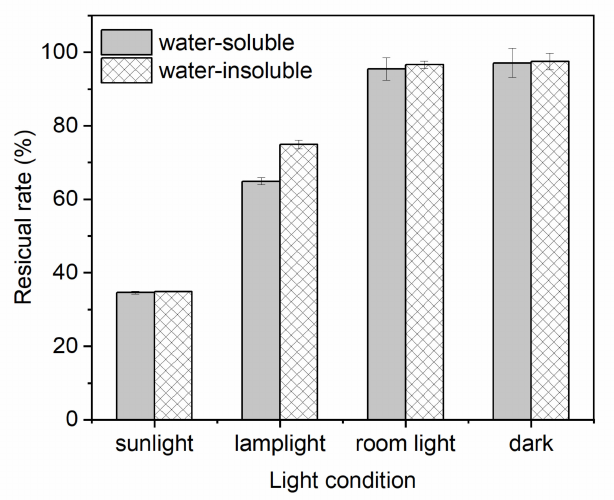
Figure 9. Light stability of water-soluble and water-insoluble gardenia blue pigments (residual